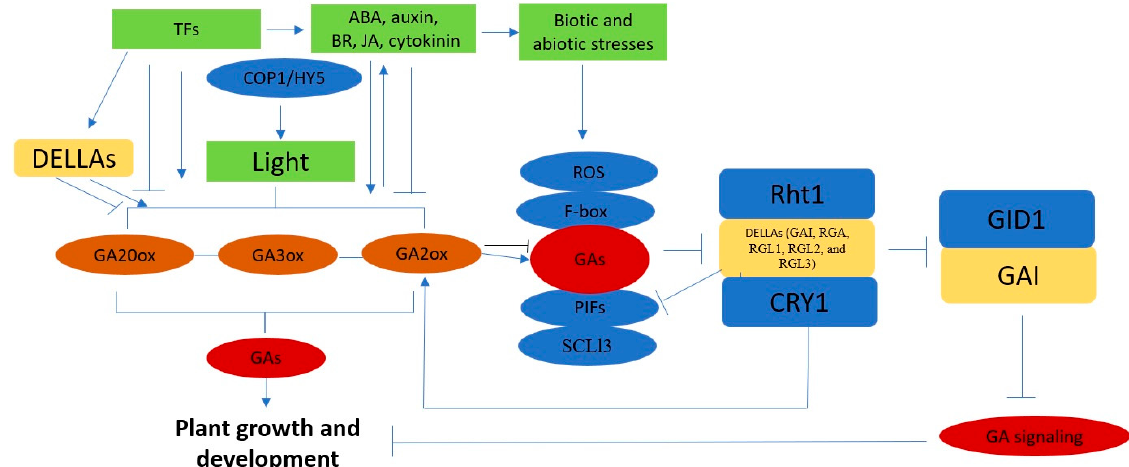
Figure 3. GA biosynthesis mechanism and inactivation of GA signaling. GA signaling was influenced by DELLAs, GID1, and GAs. Light, TFs, biotic and abiotic stresses, and COP1/HY5 affected GA binding to ROS, F-box, PIFs, and SCL13 to degrade DELLAs. CRY1 repressed GA signaling by binding with DELLA proteins (GAI, RGA, RGL1, RGL2, and RGL3) and GID1 to inhibit the GID1–GAI interaction. The green boxes indicate other factors that affect GA biosynthesis, the blue and yellow boxes indicate other genes that affect or are affected by GAs, the brown circles relate to GAs activating and inactivating genes, and the red boxes indicate bioactive GAs.